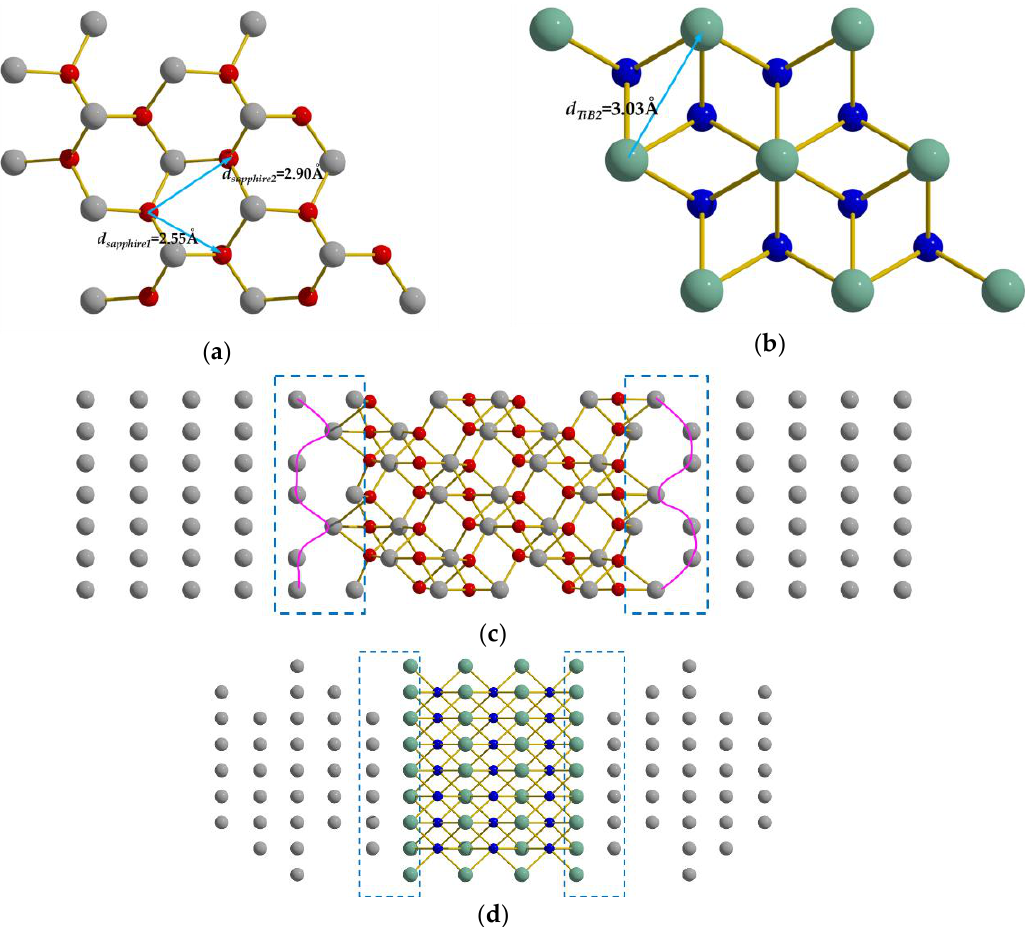
Figure 6. ( a,b ) Top view of the (0001) sapphire surface and the (0001) TiB 2 surface relaxed at 0 K. Two interatomic distances, 𝑑 𝑠𝑎𝑝𝑝ℎ𝑖𝑟𝑒1 and 𝑑 𝑠𝑎𝑝𝑝ℎ𝑖𝑟𝑒2 , exist along the < 101̅0 > direction at the (0001) sapphire surface, resulting in ~−10.75% and ~1.4% mismatches with the (111) Al ( d <110> ≈ 2.86 Å ). The large negative sapphire–Al interfacial mismatch is the main resistance for the liquid Al layering. 𝑑 𝑇𝑖𝐵2 is the interatomic distance along the < 112 ̅ 0 > direction at the (0001) TiB 2 surface. The TiB 2 –Al interfacial mismatch is ~5.43%. ( c , d ) The relaxed structures of the (0001) sapphire– (111) Al and the (0001) TiB 2 – (111) Al S/S interfaces. (Al: gray spheres; O: red spheres; Ti: green spheres; B: blue spheres). Table 3. Temperature influence on the lattice parameters of sapphire, TiB 2 , and Al, based on the ab initio molecular dynamics (AIMD)